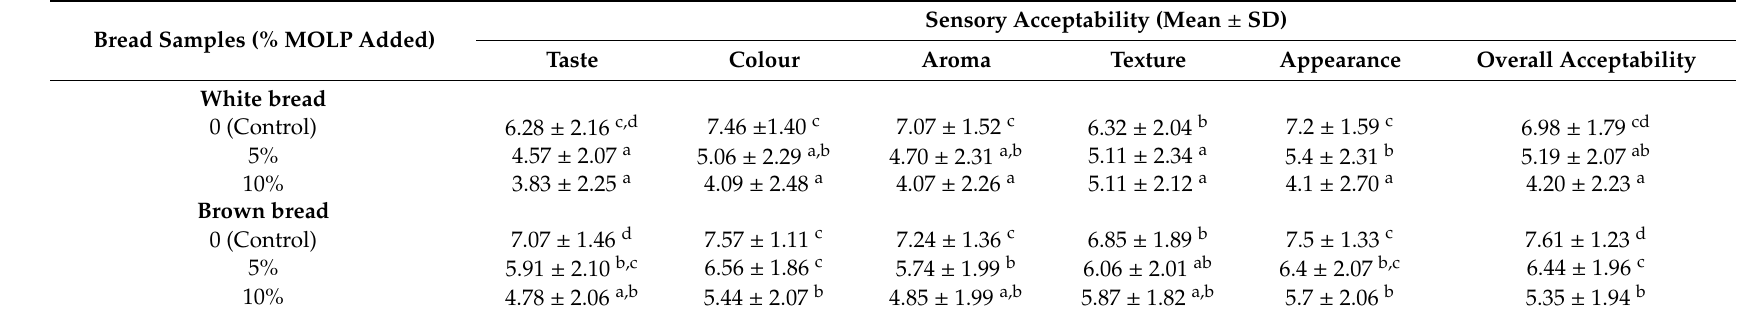
Table 7. The e ff ect of Moringa oleifera leaf powder (MOLP) on sensory acceptability of white and brown breads. Bread Samples (% MOLP